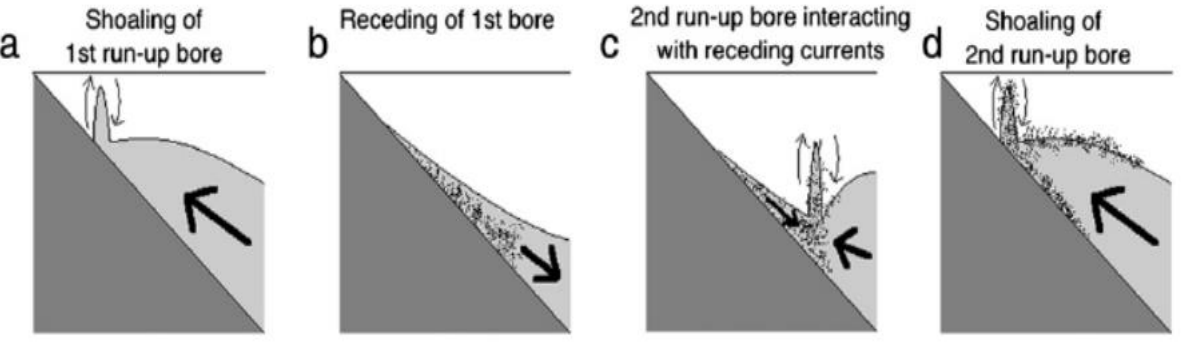
Figure 5. Schematic image of sediment resuspension induced by internal bores [35].